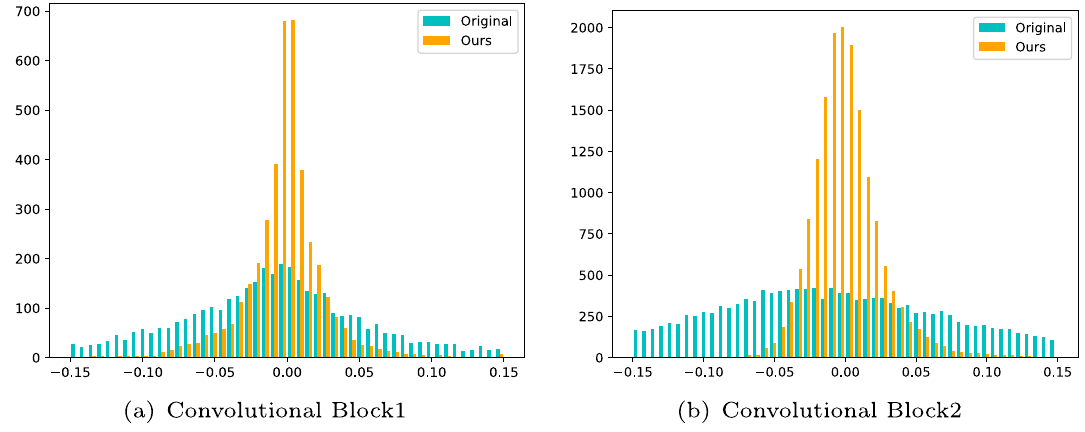
Fig. 4 The Histogram of the weights, sampled from the last two convolutional blocks. It is clear to see ours within a smaller and more symmetric